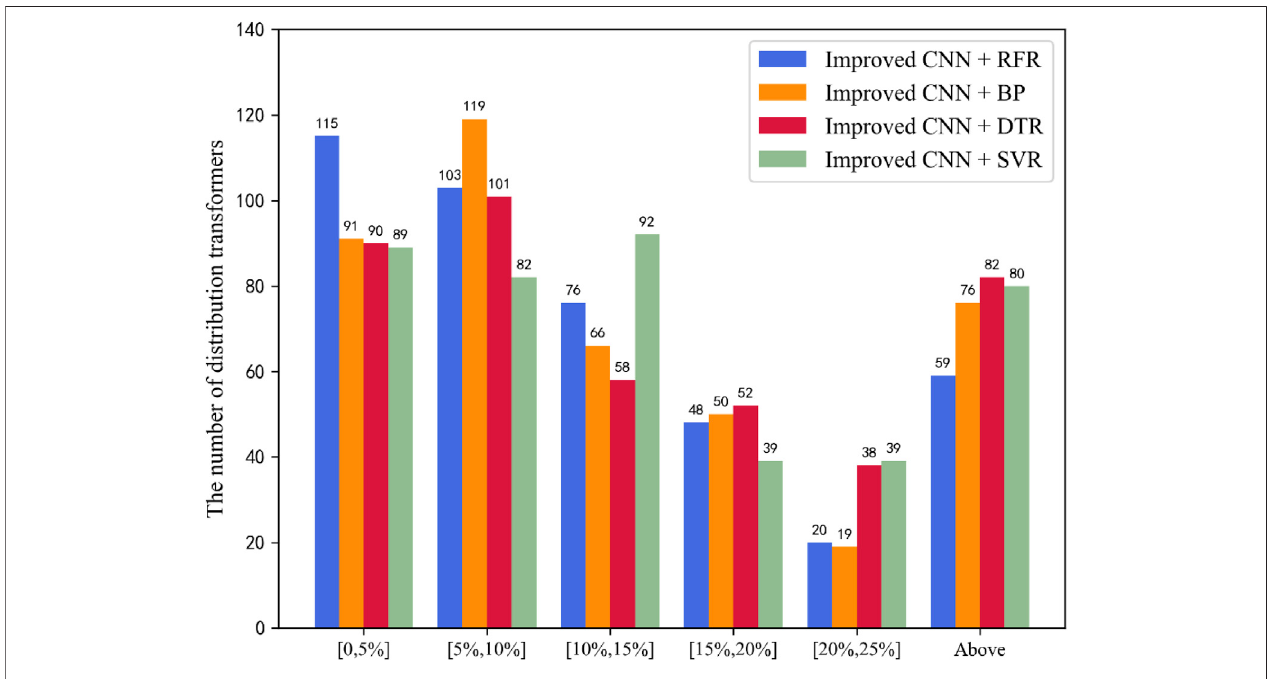
FIGURE 11 | The number of distribution transformer in different error interval.